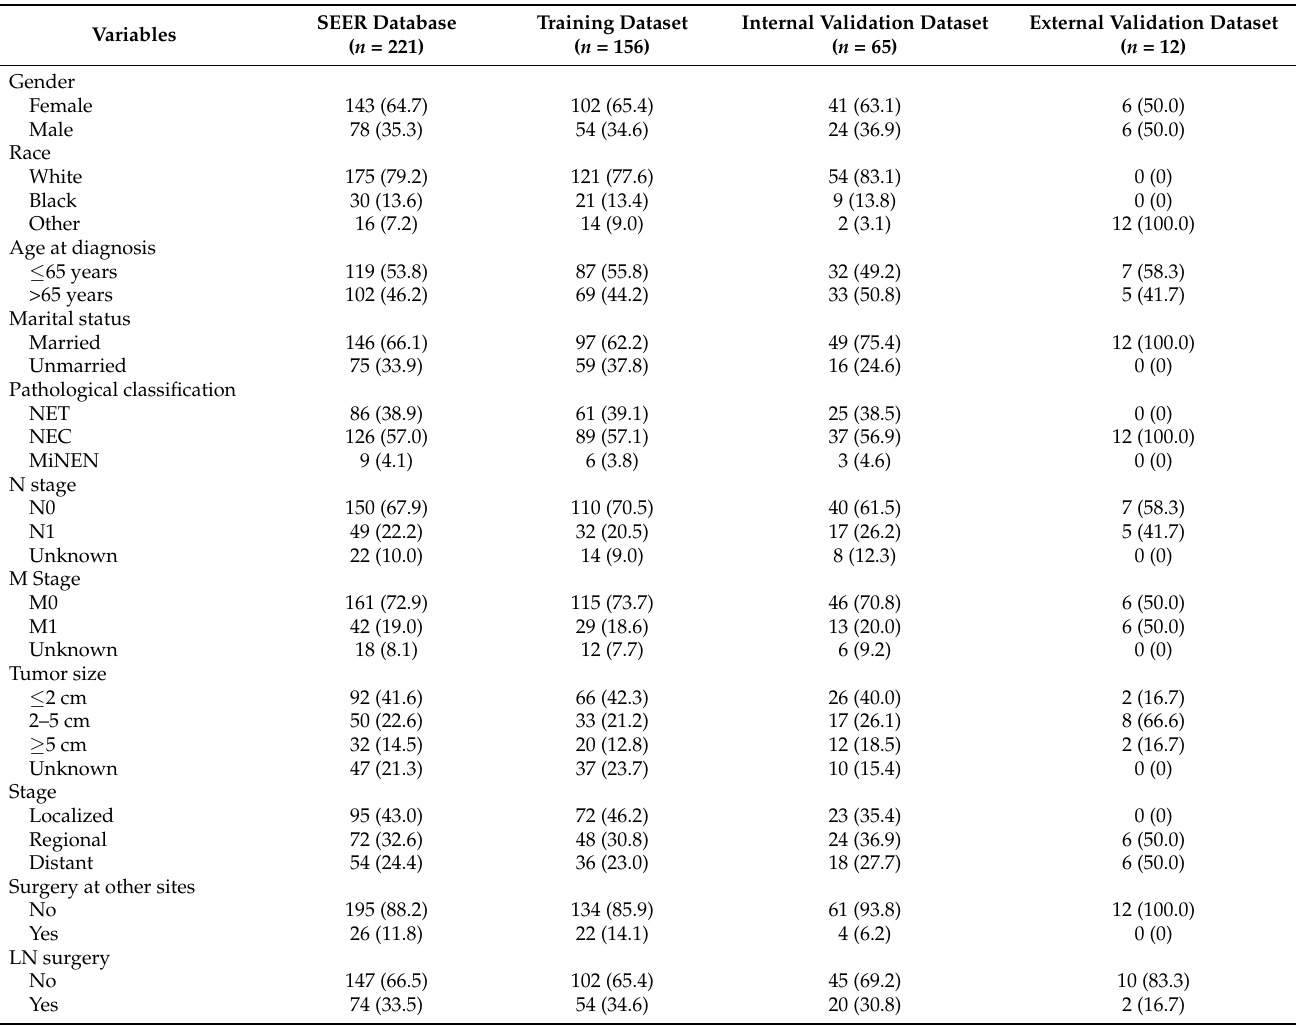
Table 1. Demographic and clinicopathological characteristics of patients with GB-NENs receiving primary tumor